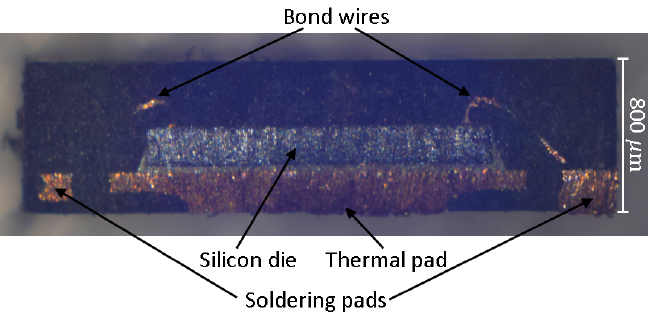
Figure 3. Cut image through the amplifier. The silicon die with one clearly visible bond wire (right side) and another bond wire barely visible (left